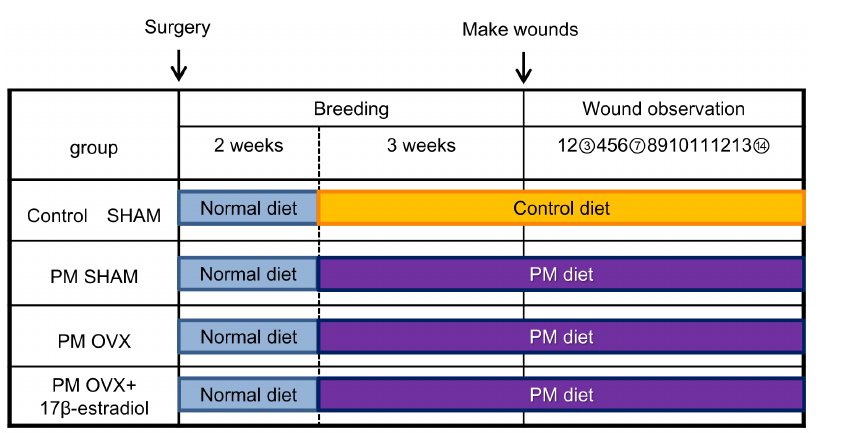
Fig. 1. Research schedule. Mice were subjected to sham surgery (SHAM) or ovariectomy (OVX) and divided into four groups: Control SHAM group, protein malnutrition (PM) SHAM group, PM OVX group and PM OVX + 17 b -estradiol group. Three different colors show different diets. After surgery, all groups were fed a normal diet for 2 weeks (blue box) as a period of recovery from the surgery. Then, the Control SHAM group was fed on a control diet (orange box) for 3 weeks, but the other 3 groups were fed on a PM diet (purple box) for 3 weeks. At 5 weeks after surgery, two circular full-thickness skin wounds (4 mm in diameter) including the panniculus carnosus muscle on both sides of the dorsum of the mouse were made with a Kai sterile disposable biopsy punch. The process of wound healing was observed every day for 15 days, and wounds were harvested on days 3, 7 and 14 after wounding (circled